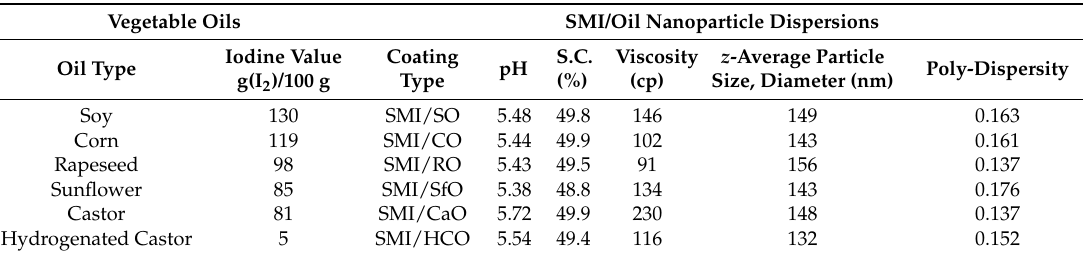
Table 1. Characteristics of the oils and SMI/oil nanoparticle dispersions for paper coatings. Vegetable